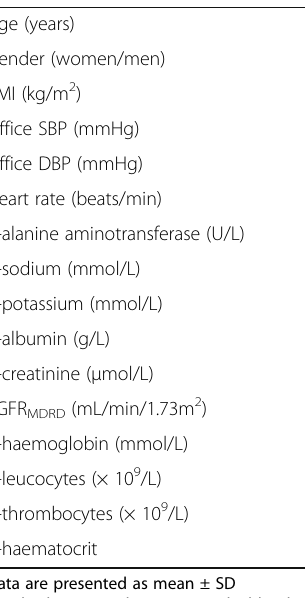
Table 1 Clinical and biochemical characteristics ( n = 18)